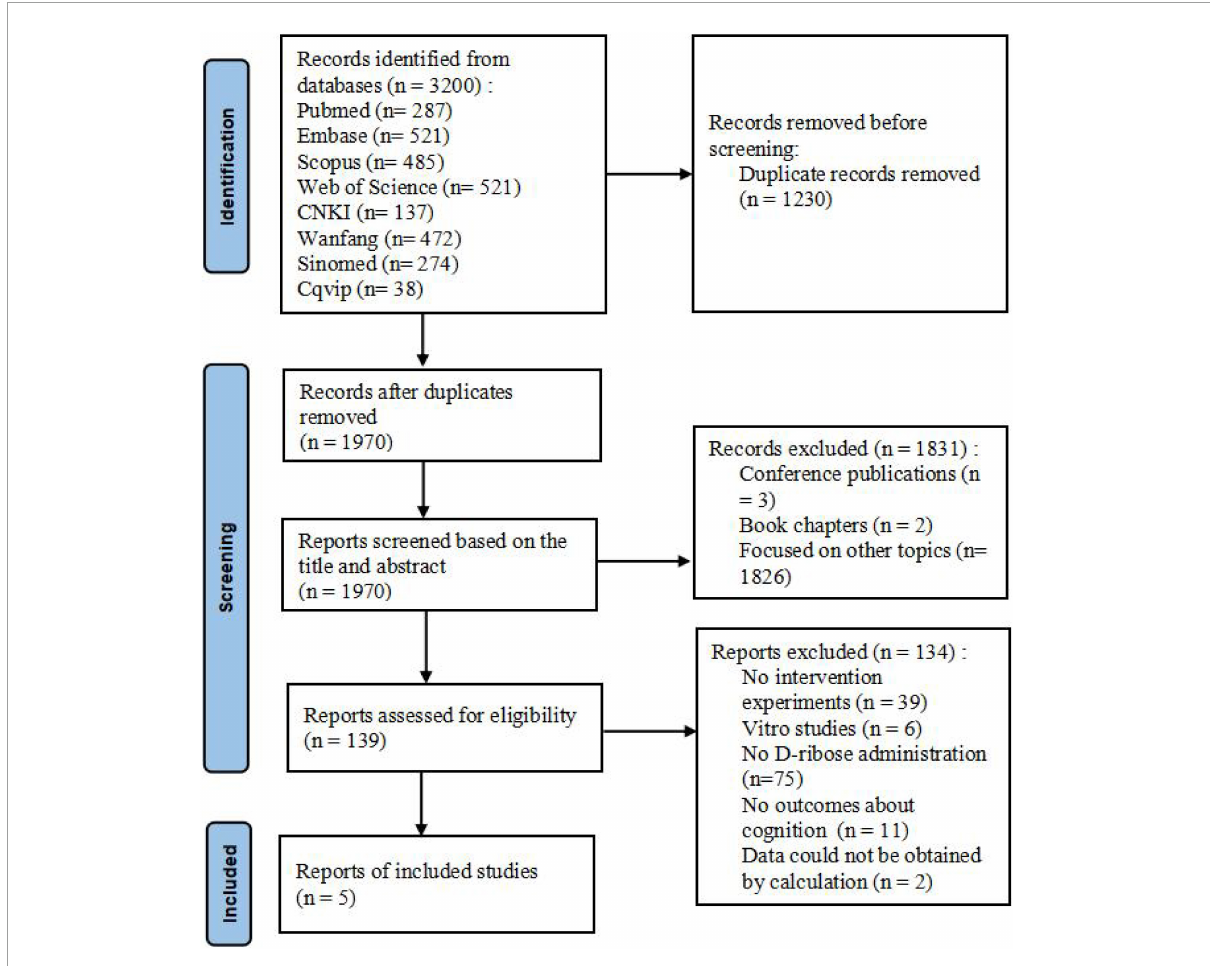
FIGURE1 Prisma flowchart depicting the article selection process.